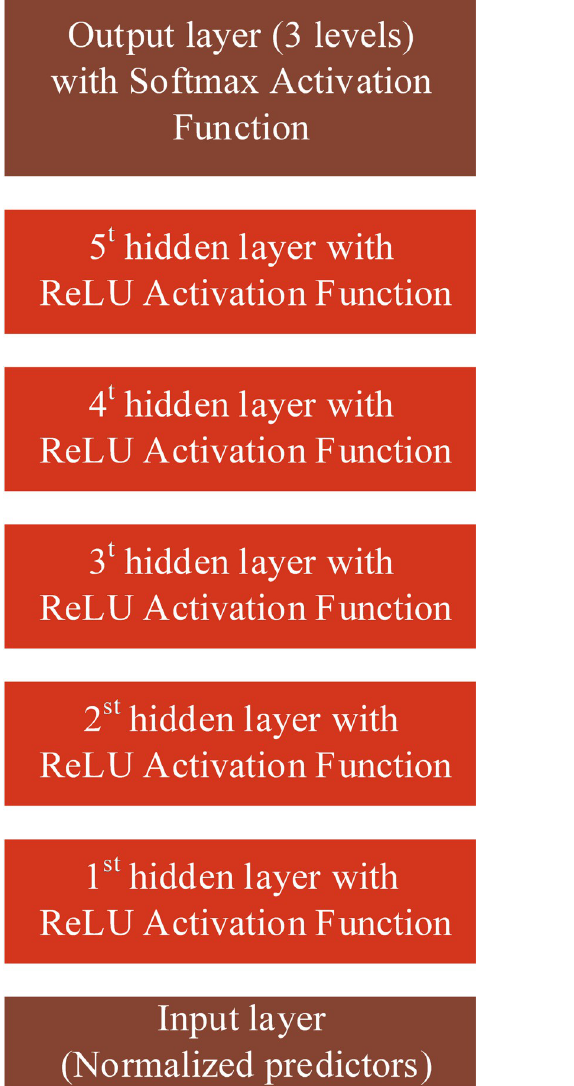
Fig 1. Network architecture of the proposed MLP